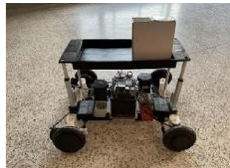
Figure 9. Low load test.